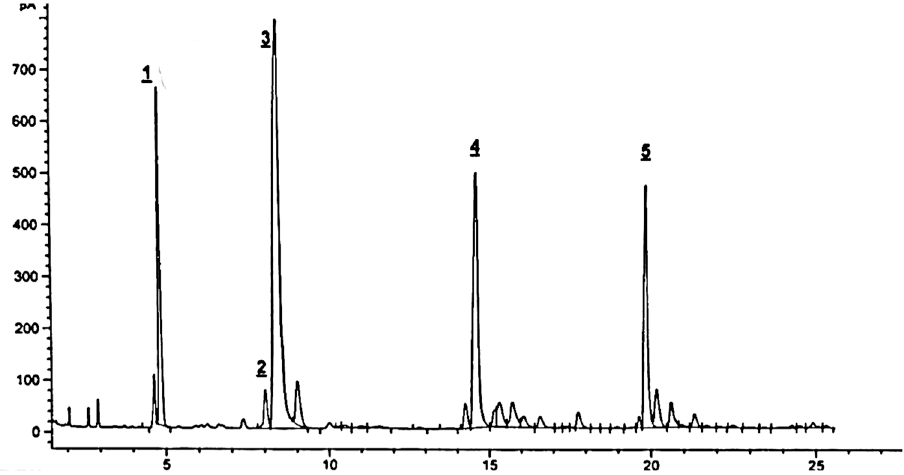
Figure 6. GC/FID chromatogram of FAME in NCF; 1: palmitic acid; 2: GLA; 3: LA; 4: EPA; 5: DHA .